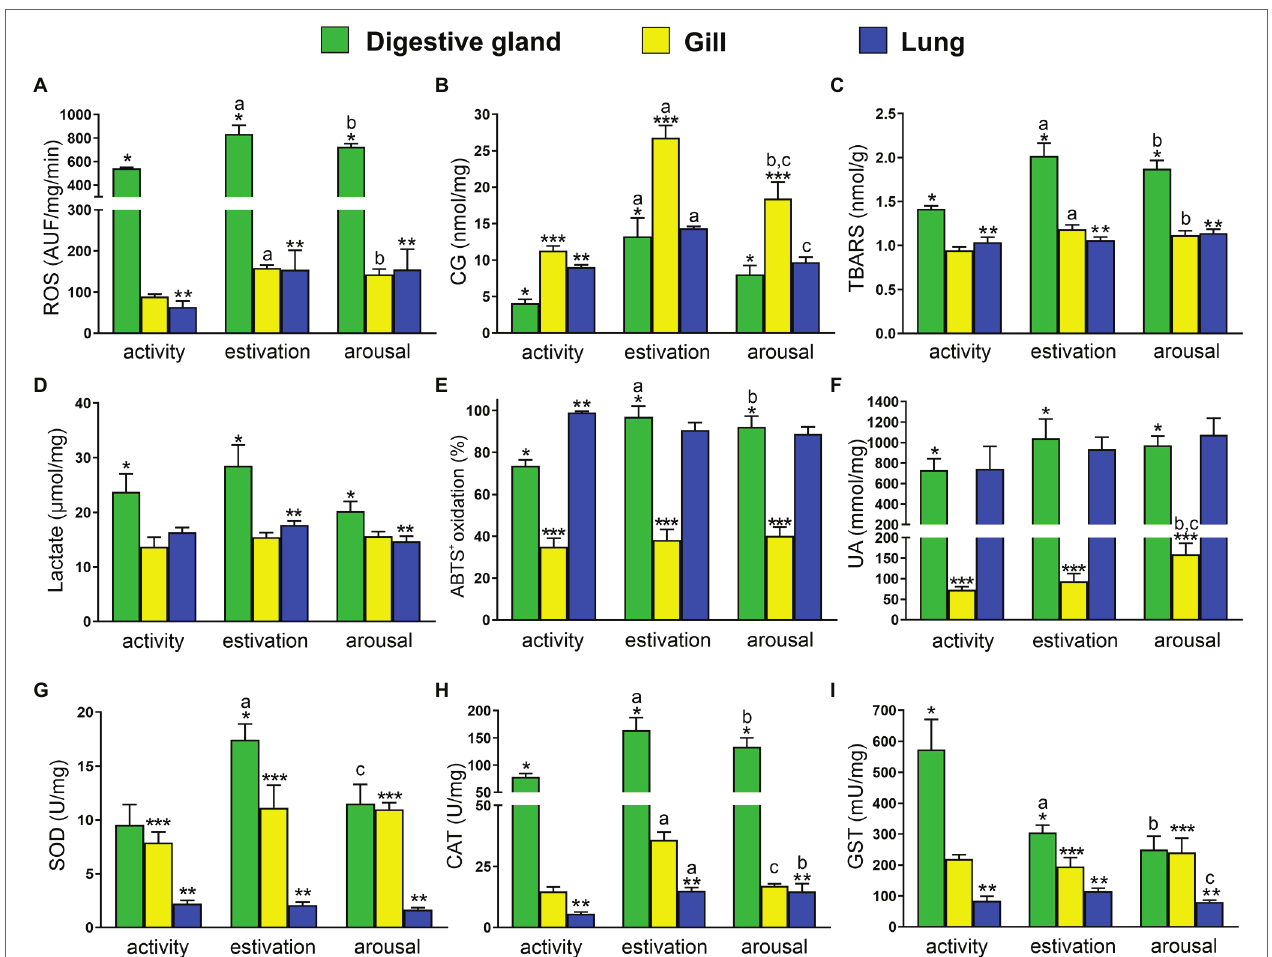
FIGURE 1 | Physiological responses of Pomacea canaliculata exposed to short term activity–estivation–arousal cycle. (A) Reactive oxygen species (ROS); (B) protein oxidative damage (carbonyl groups, CG); (C) thiobarbituric acid reactive substances (TBARS); (D) lactate; (E) percent of ABTS + oxidation; (F) non-enzymatic antioxidant (uric acid); (G–I) enzymatic antioxidant defenses [superoxide dismutase (SOD), catalase (CAT), and glutathione S-transferase (GST)], in the digestive gland (green), gill (yellow), and lung (blue). Mean ± SEM. Significant differences between activity, estivation, and arousal groups in the same organ ( p < 0.05, one-way ANOVA, Newman–Keuls ʼ s test) are indicated as follows: a activity vs. estivation, b activity vs. arousal, c estivation vs. arousal. Significant differences between organs at the same time of the activity–estivation–arousal cycle ( p < 0.05, one-way ANOVA, Newman–Keuls ʼ s test) are indicated as follows: * midgut gland vs. gill, ** midgut gland vs. lung, and *** gill vs.